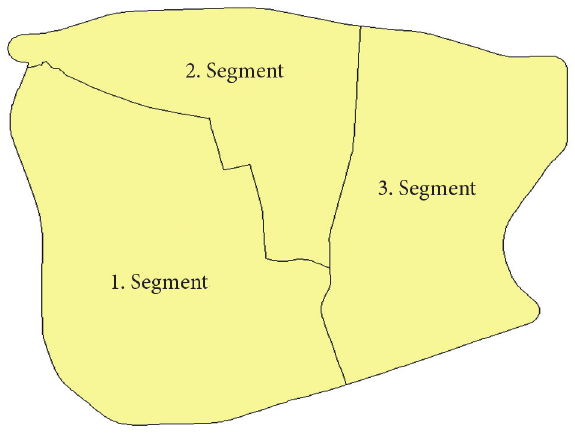
Fig. 1. Panevėžys city central